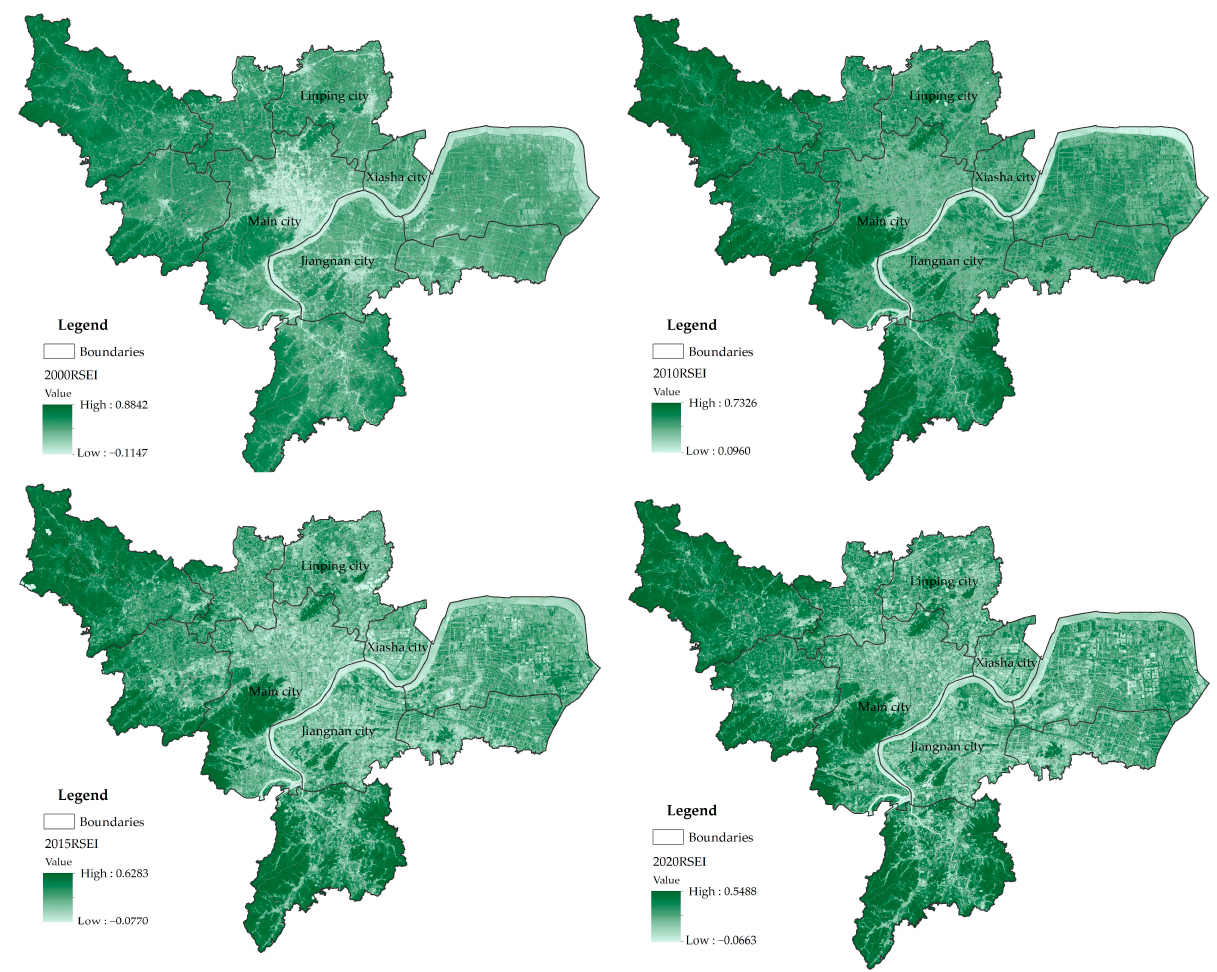
Figure 5. The RSEI in Hangzhou in different years.